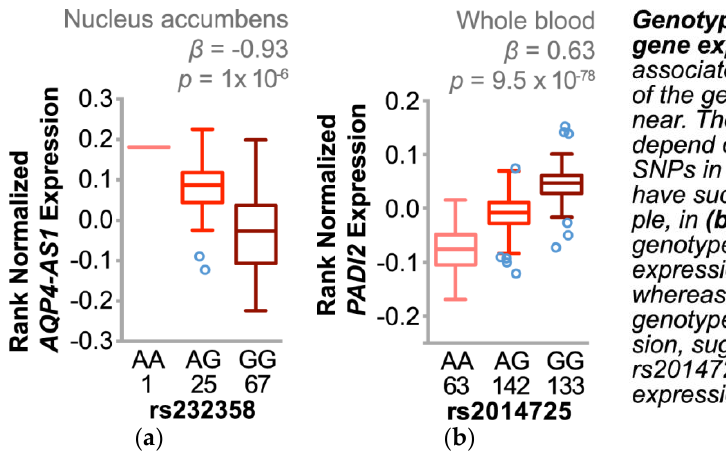
Figure 7. Expression of quantitative trait loci involving candidate SNPs associated with ΔSBP. Cis eQTL analysis of the eSNP rs232358 and rs2014725 with the number of subjects, genotype, and corresponding expression levels of either ( a ) AQP4-AS1 or ( b ) PADI2 is represented by boxplots (5 – 95% confidence intervals) with outliers identified (open circles). The p value and beta coefficient ( β ) of the linear regression are noted.